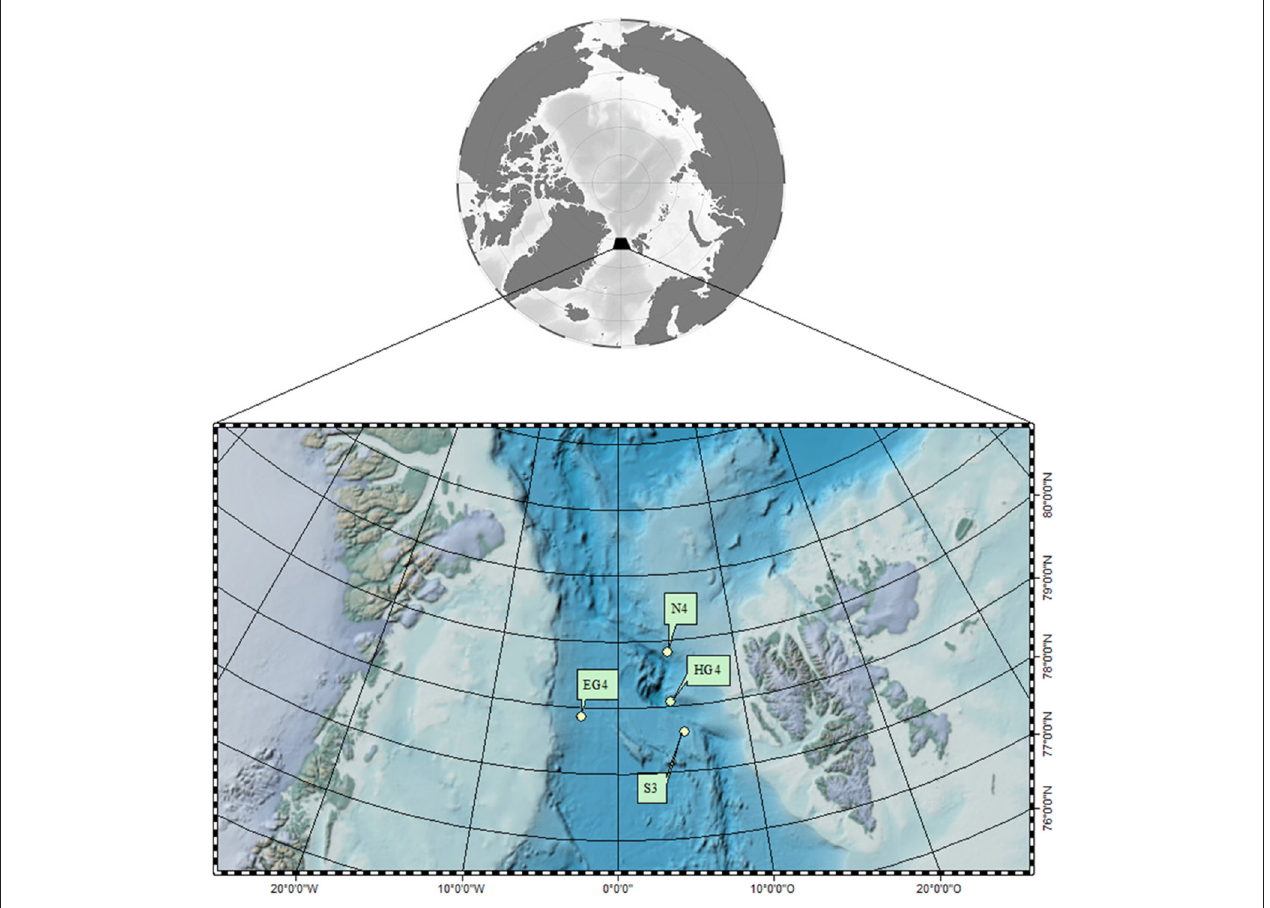
FIGURE 1 | Location of the sampling stations in the Long-Term Ecological Research (LTER) observatory HAUSGARTEN (78. 42 ◦ N, 2.27 ◦ E and 79.50 ◦ N, 6.20 ◦ E) on a global map and a more detailed overview of the Fram Strait based on the Arctic Bathymetry Basemap (IBCAO/GEBCO_08). Stations sampled (from 24th of July until 4th of August 2015) for this project are indicated by dots (for exact positions see coordinates listed in the Supplementary Table S1). Landmasses depict Greenland and Spitsbergen, light green color marks continental